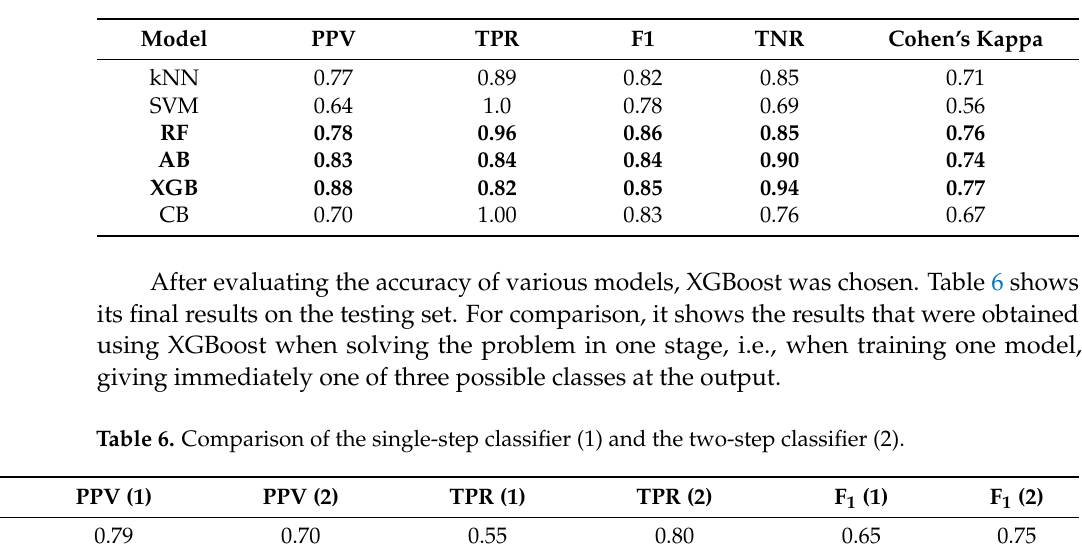
Table 5. Classifier_B results.